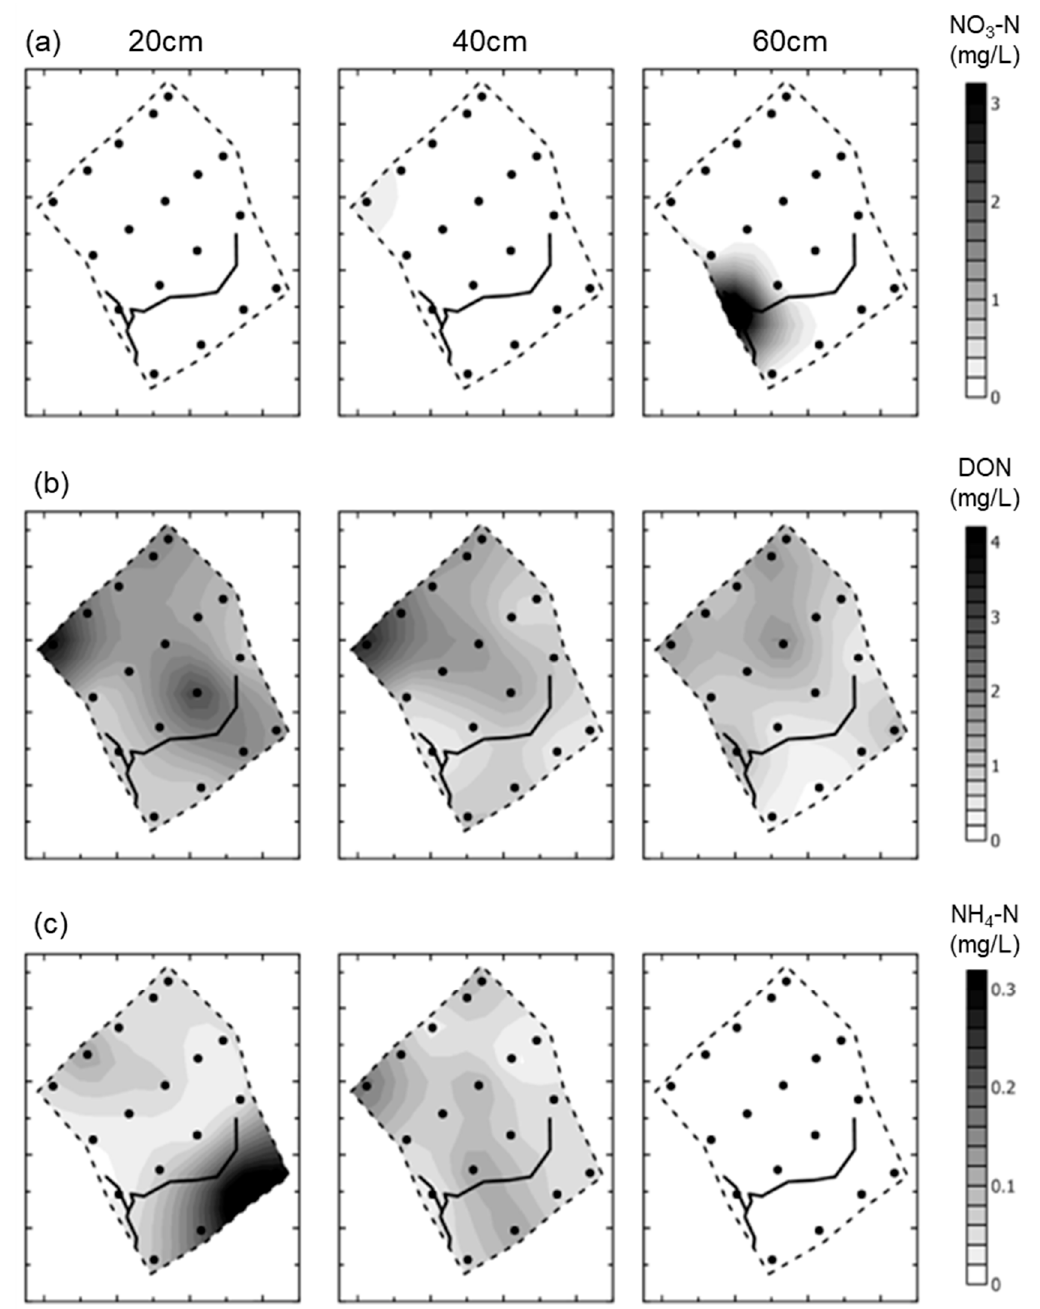
Figure 7. Soil porewater N speciation under baseflow conditions (3 August 2004). Sampler locations are shown as black dots, as detailed in Figure 2. ( a ) shows NO 3 -N concentrations across the wetland at 20, 40 and 60 cm depth, while ( b ) shows DON concentrations, and ( c ) shows NH 4 -N concentrations across the site at these same depths.